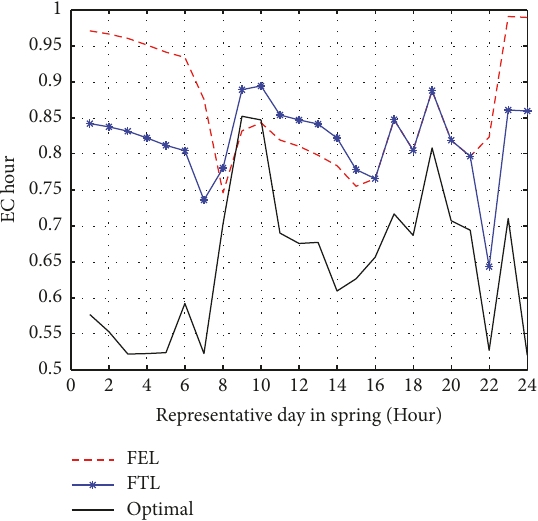
Figure 7: Comparison of three strategies in a spring day.